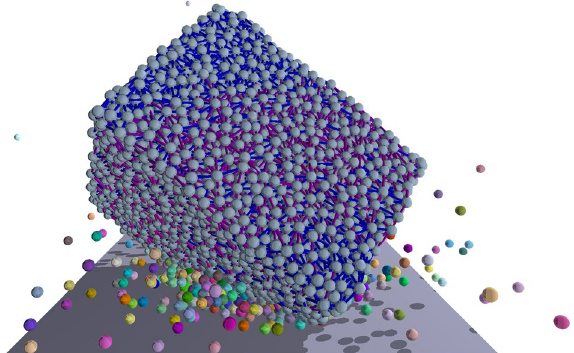
Figure 1. A snapshot of the time evolution of the first impact of a sample with a hard wall. The initially angular body hits the wall close to one of its corners. Most of the fragments are single particles flying at a high speed. Colors are randomly assigned to the fragments. The intact cohesive contacts are represented by lines connecting the spherical particles.